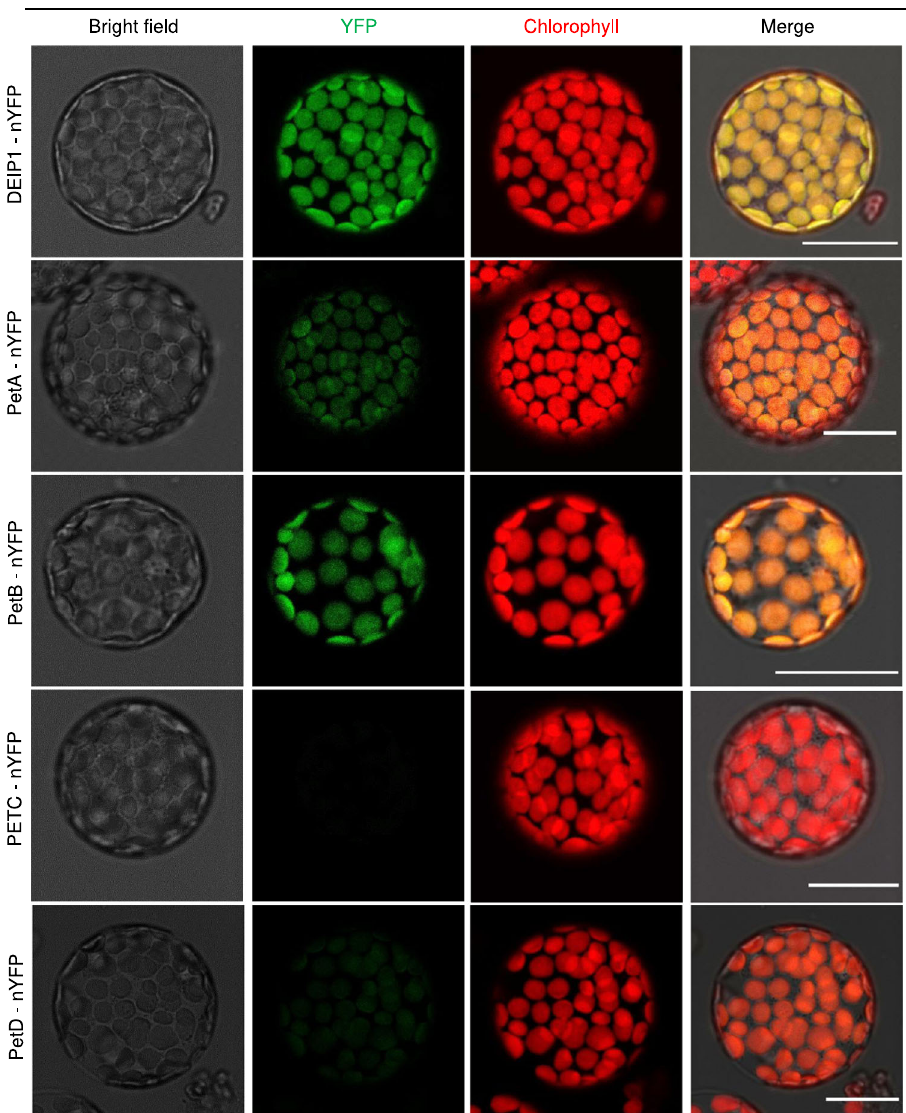
Fig. 8 BiFC analyses to verify the interaction of DEIP1 with Cyt b 6 f complex subunits in chloroplasts. Bimolecular fl uorescence complementation (BiFC) assays with the DEIP1-cYFP fusion protein in tobacco protoplasts are shown. Interactions were assessed with the nYFP fused to the C-terminus of DEIP1, PetA, PetB, PETC and PetD. The endogenous transit peptide was employed for DEIP1, and the pea RBCS chloroplast transit peptide was employed for all Cyt b 6 f subunits. The bright fi eld (BF), YFP (green), chlorophyll auto fl uorescence (red) and the merged images are depicted. Representative images were selected based on the observation of 80 protoplasts in two independent experiments for each interaction. Scale bars: 20 μ